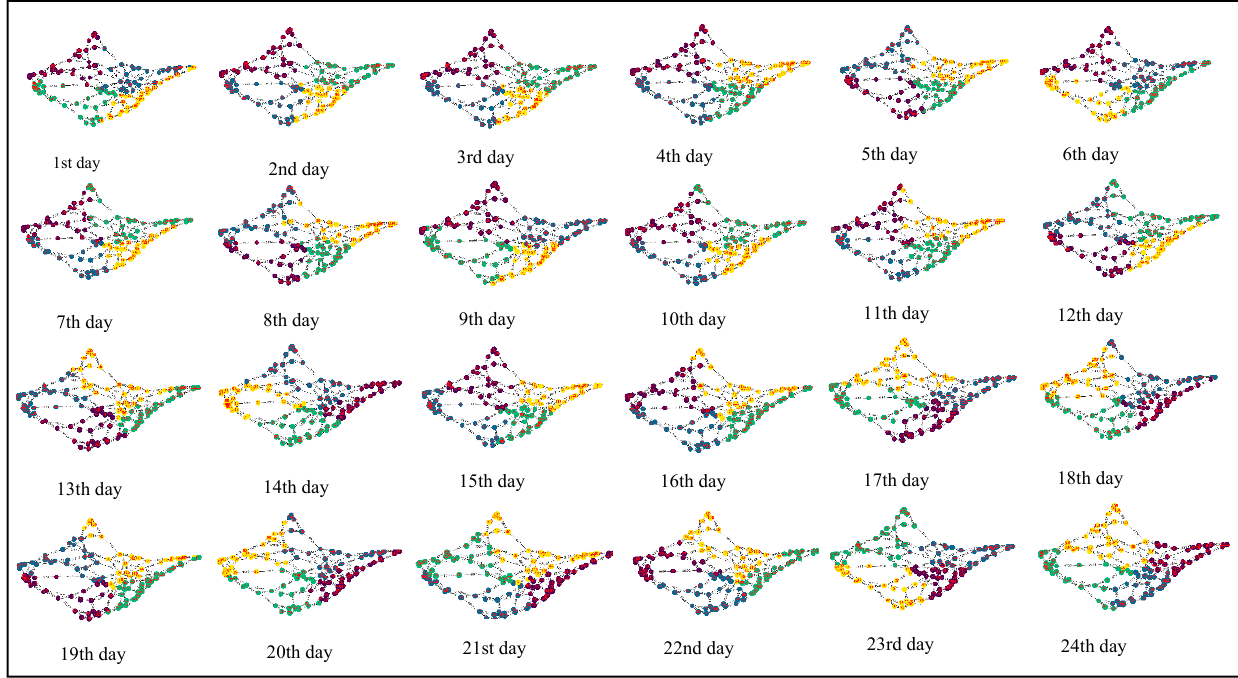
Figure 10. Network clustering at different times.